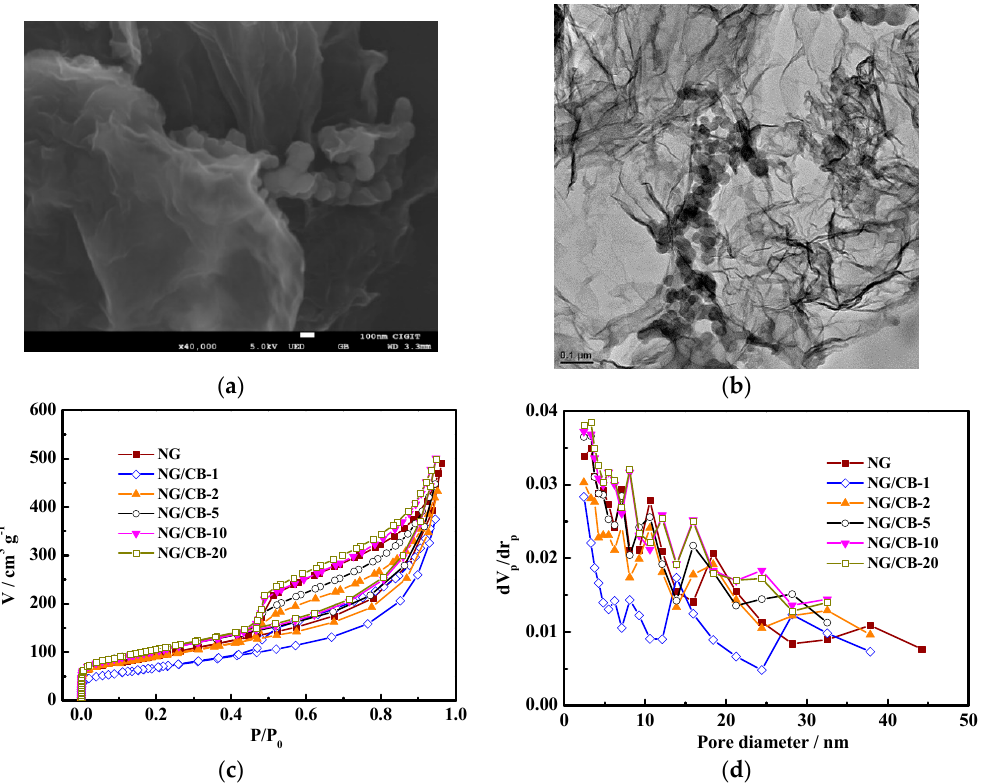
Figure 4. SEM ( a ) and TEM ( b ) images of NG/CB-10, and N 2 adsorption and desorption isotherms ( c ) and pore size distribution curves ( d ) of NG/CB-x electrocatalysts.